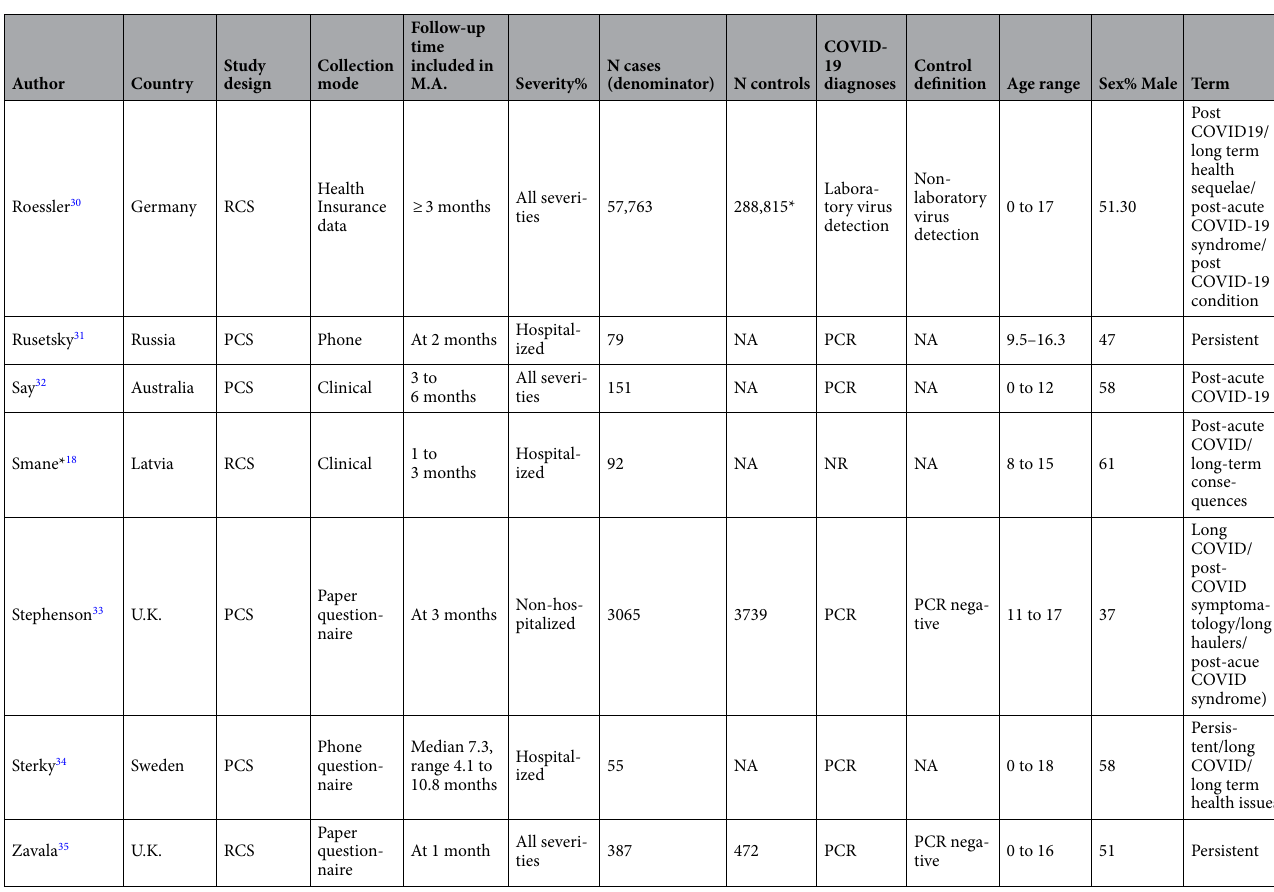
Table 1. General characteristics of studies. Controls: did not present numbers, therefore it could not be used CSS cross-sectional study, DM diabetes mellitus, NA not applicable, NR not reported, MA meta-analysis,